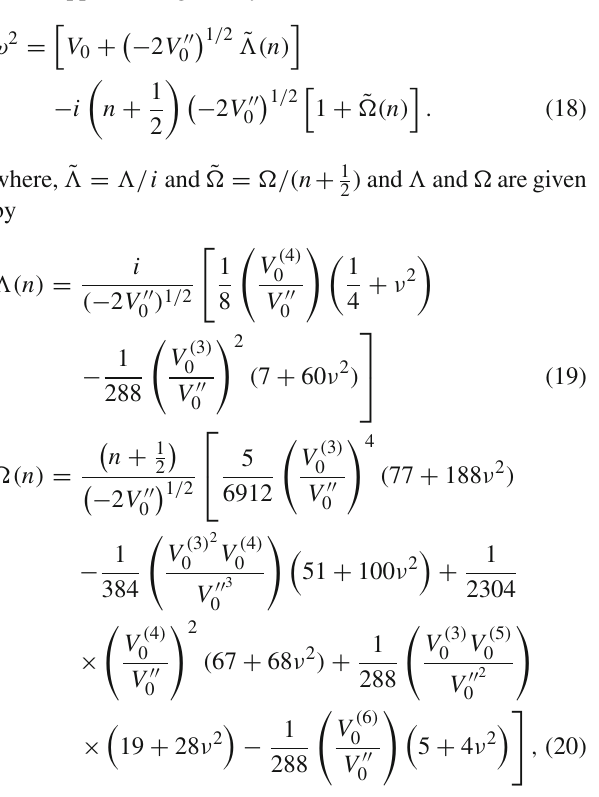
The formula for quasinormal frequencies using third order WKB approach is given by